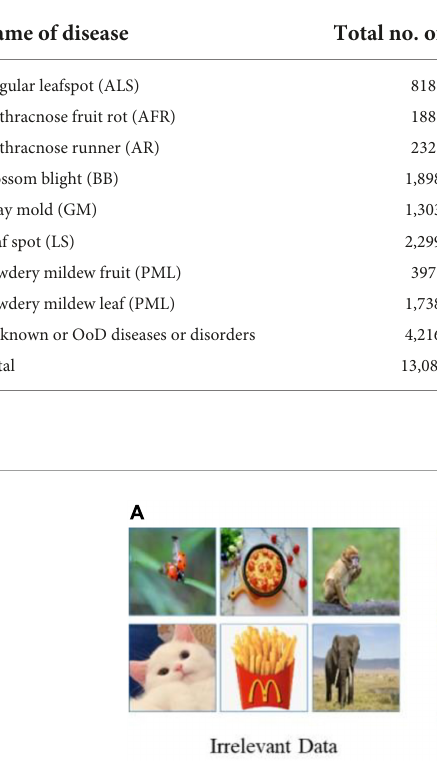
TABLE 2 Image dataset of strawberry diseases and unknown diseases.